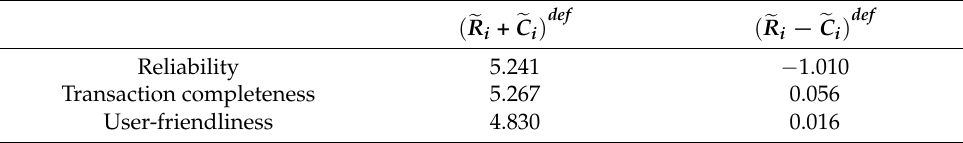
Table 7. Sum of ( (cid:101) R i + (cid:101) C i ) ical